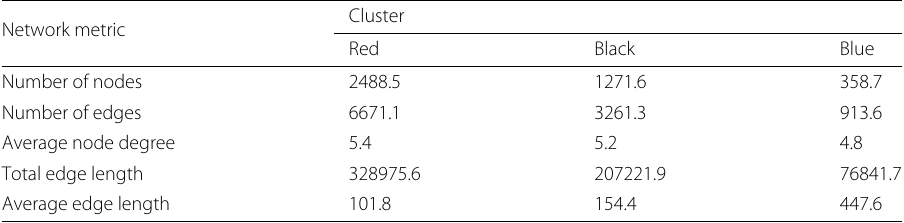
Table 1 Average network metrics of urban street networks in the three clusters in Fig. 6a Cluster Network metric Red Black Blue Number of nodes 2488.5 1271.6 358.7 Number of edges 6671.1 3261.3 913.6 Average node degree 5.4 5.2 4.8 Total edge length 328975.6 207221.9 76841.7 Average edge length 101.8 154.4